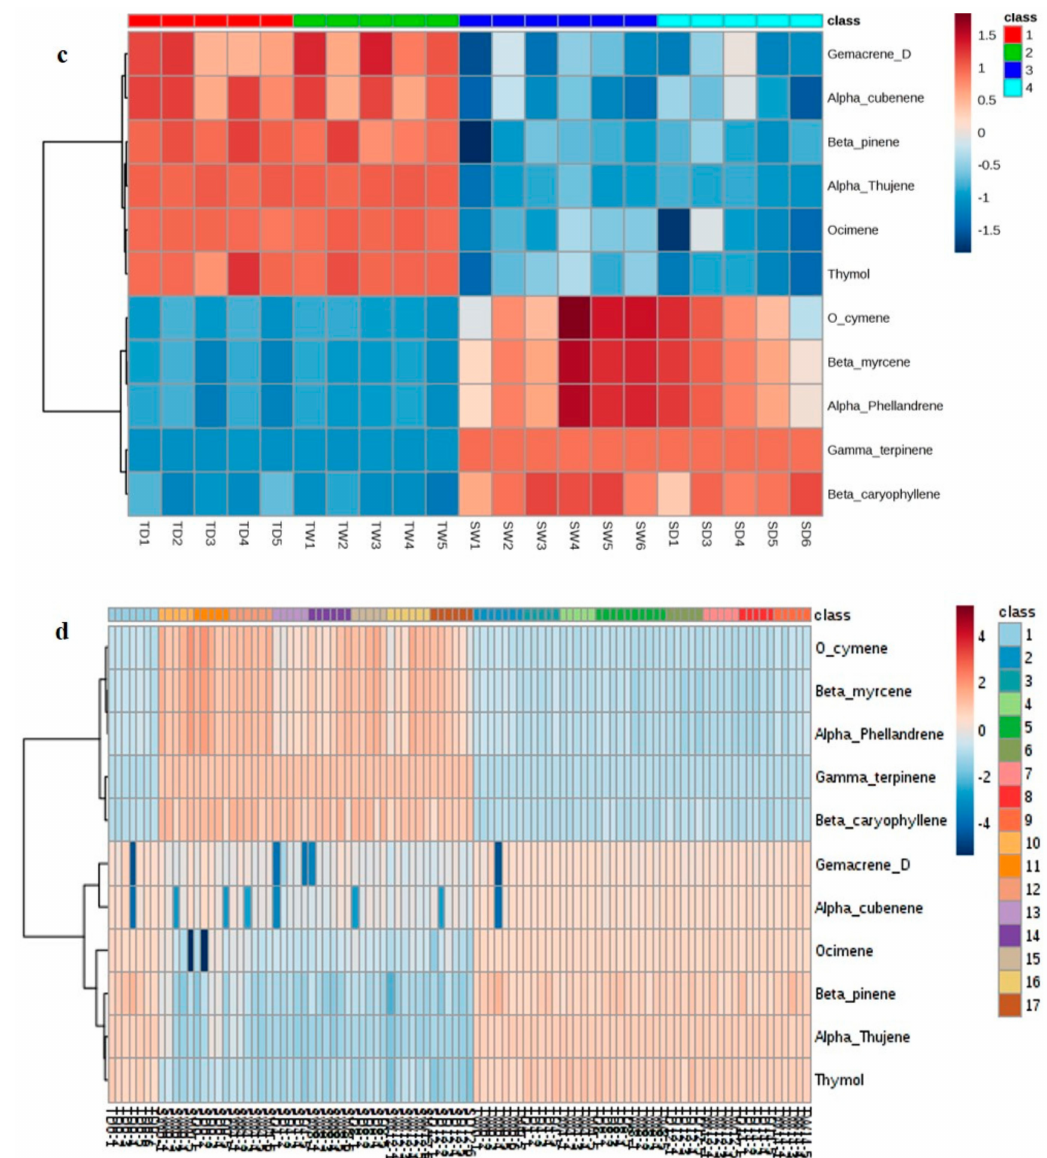
Figure 5. The hierarchical clustering and heat map of the data. The peaks were divided into given groups (TD, tolerant drought-stressed; TW, tolerant watered; SD, sensitive drought-stressed; SW, sensitive watered) after four ( a ), 8 ( b ) and 12 ( c ) days of water limitation. ( d ) The total heat map (days 0–14). The numbers represent the corresponding sample numbers and di ff erent colors are indicative of the relative abundance of each volatile in di ff erent